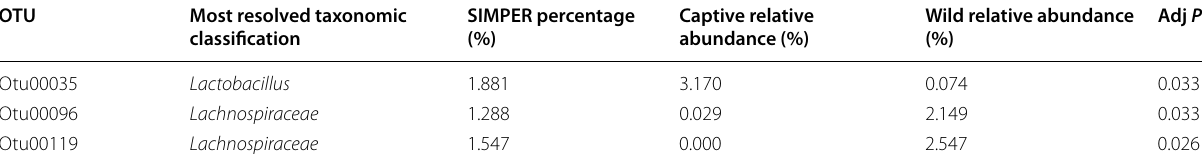
OTUs were identified with SIMPER and statistically tested with Kruskal–Wallis tests. P -values were corrected for false discovery rate using the Benjamini–Hochberg procedure. Only OTUs that accounted for 1% of the differences in beta diversity and had adj P < 0.05 were considered significant ≥